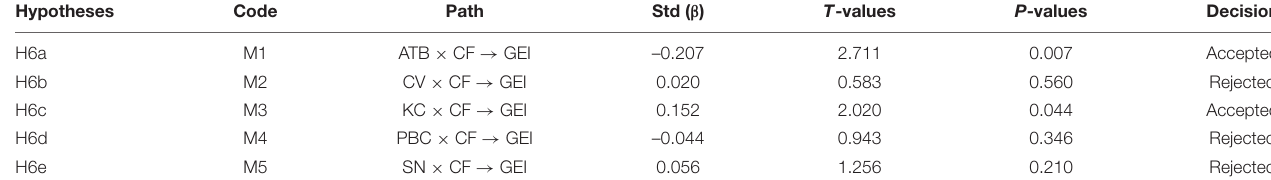
TABLE 7 | Moderating effect.